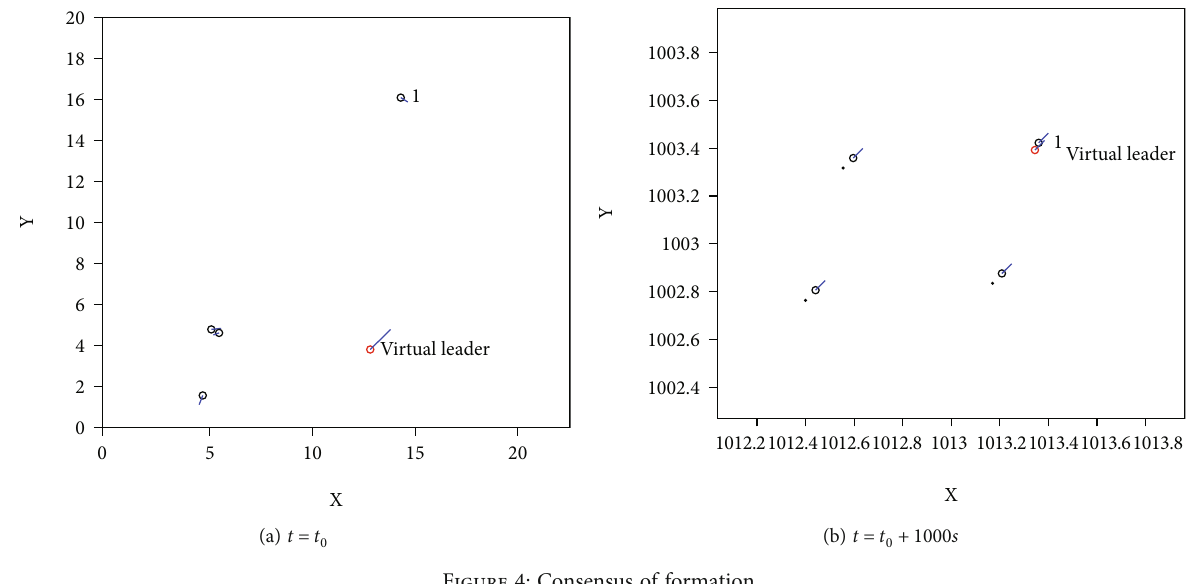
Figure 4: Consensus of